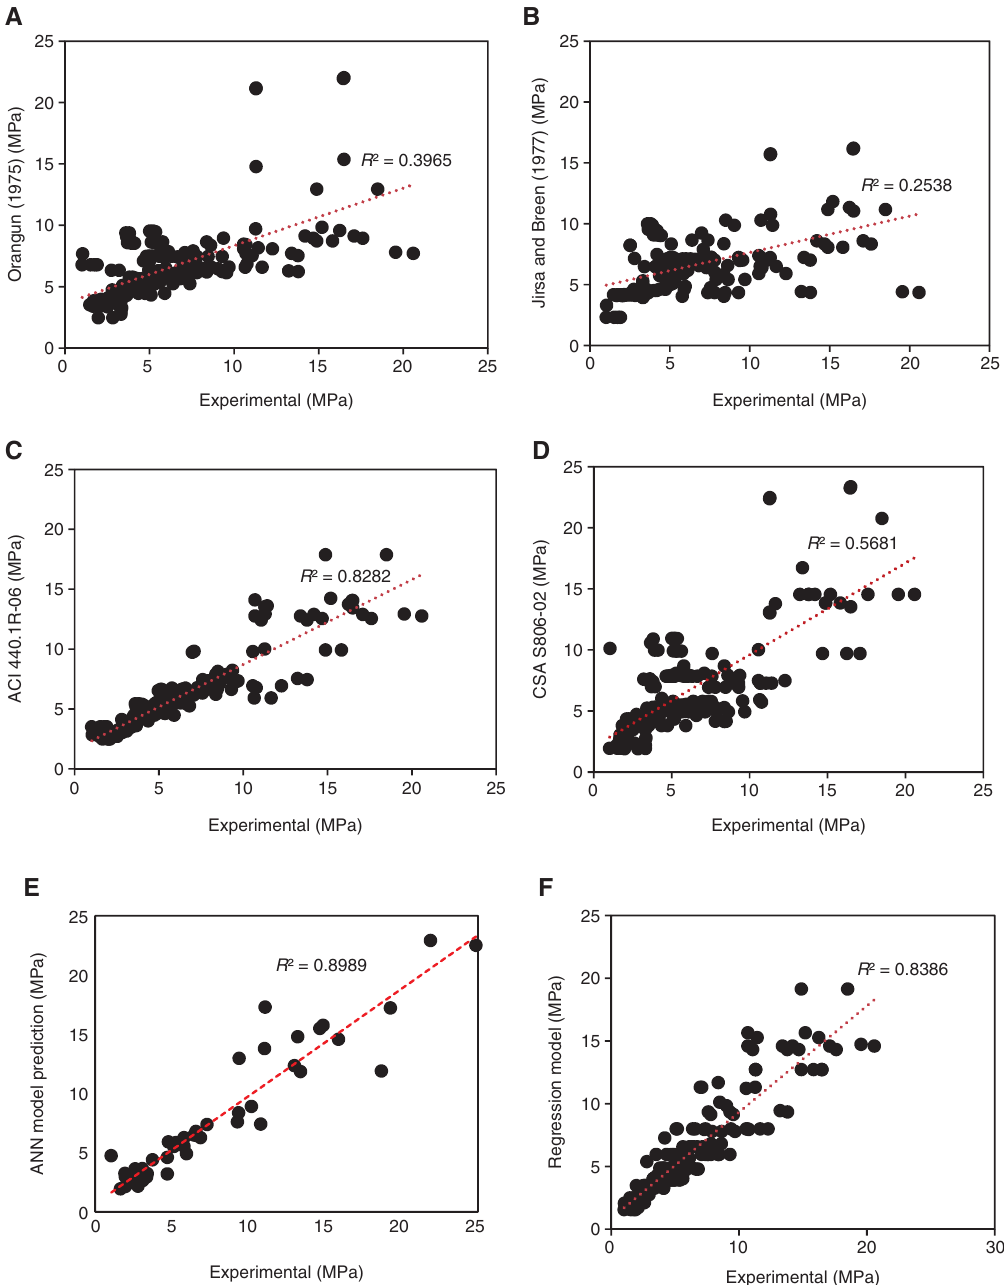
Figure 18: Comparison of experimental FRP bond strength and prediction method of (A) Orangun (1975), (B) Jirsa and Breen (1977), (C) ACI 440.1R-06, (D) CSA S806-02, (E) ANN and (F) regression